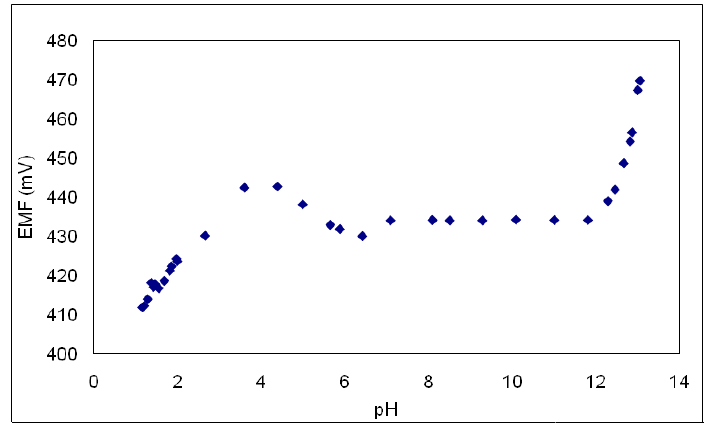
Figure 8. The pH function of bromide-selective sensor.